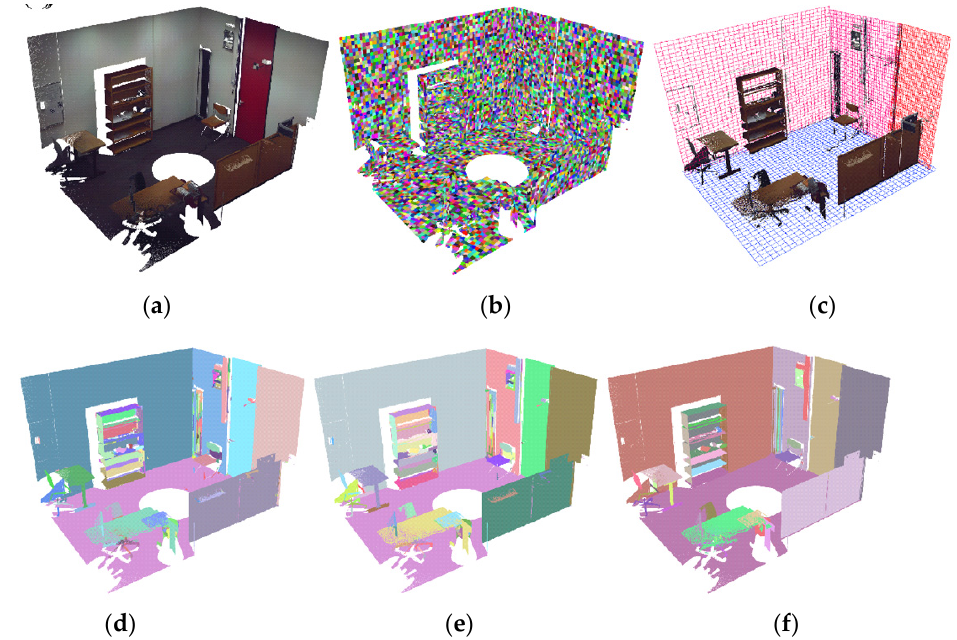
Figure 7. The segmentation result of Room-L9. ( a ) Raw point clouds ( b ) The generated surface patches. ( c ) The extracted indoor structural planes set and leftover points of the scene. ( d ) The indoor segmentations after multi-constraint graph clustering. ( e ) The final segmentation result after post-refinement. ( f ) The ground truth.